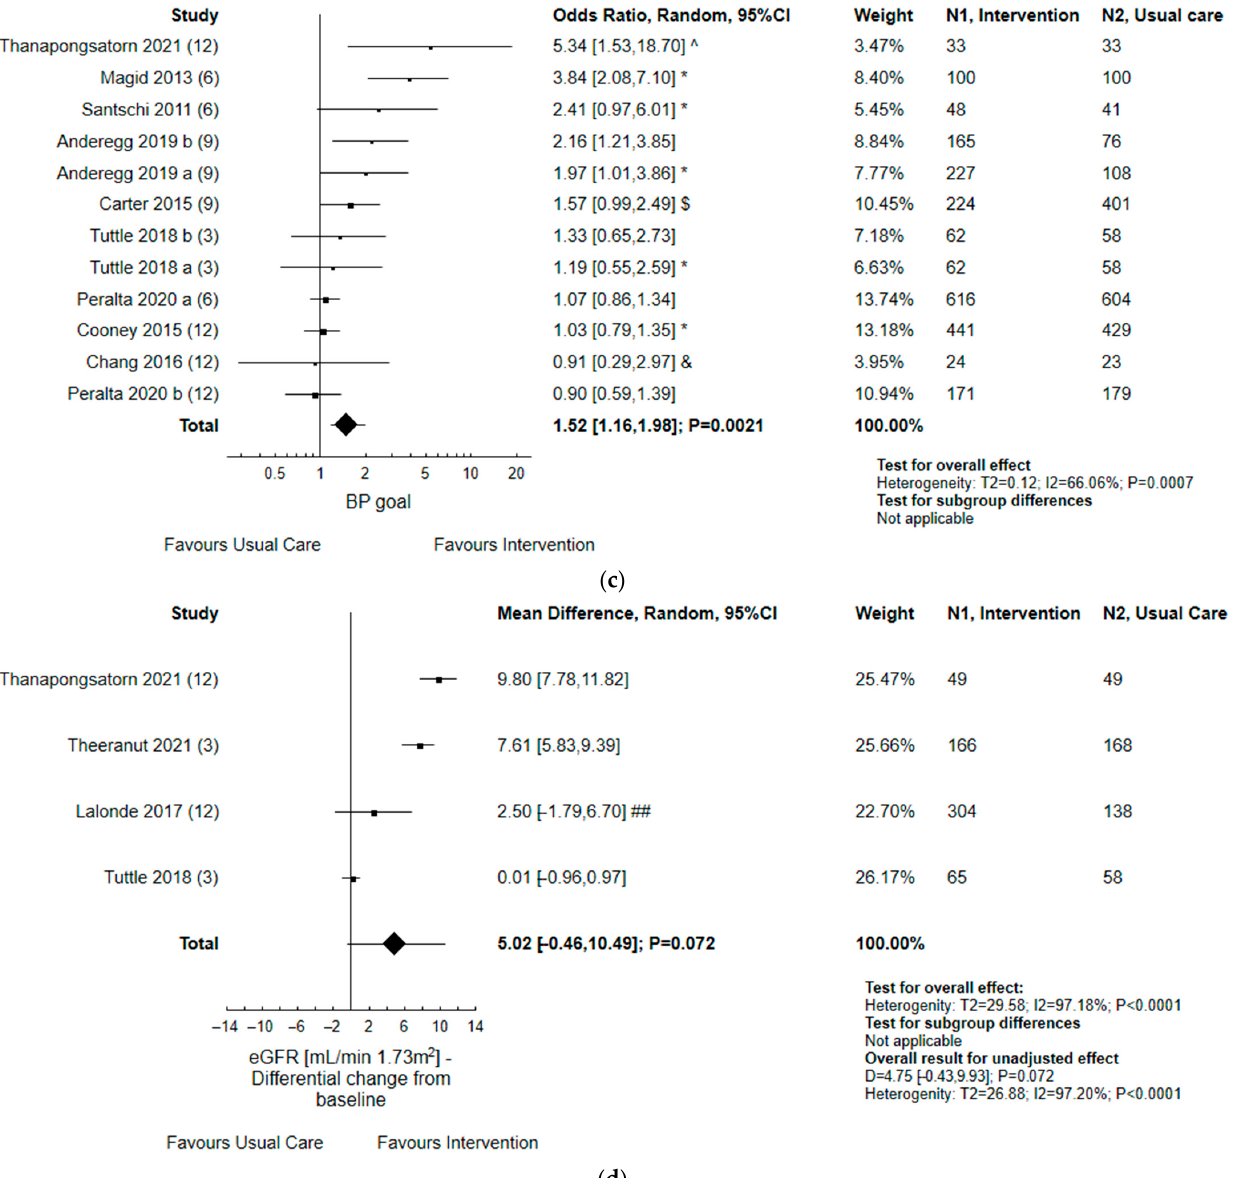
Figure 4. Forest plot of comparison: pharmacist contribution to comprehensive intervention vs. usual care for continuous and dichotomous data concerning clinical outcomes [12–15,17–22,24,27–29,36,37]. Differential change from baseline in SBP ( a ) and DBP ( b ); patients with an achieved BP goal ( c ); differential change from baseline in eGFR ( d ); #—adjusted for sex, baseline systolic BP, smoking status, body-mass index, and cluster characteristics (mean pharmacist year since graduation); ##—adjusted for the clinical variable at baseline (eGFR), interaction between study group and clinical variable at baseline, and patient’s age, sex, highest level of education, and eGFR, as well as pharmacist being an associate clinician and receiving remuneration for pharmaceutical opinions; BP goal was defined as <140/90 mmHg, except for: &—140/90 mmHg for non-proteinuric CKD and <130/80 for proteinuric CKD; ^—<140/90 mmHg for non-hypertensive patients, and <130/80 mmHg for hypertensive patients; $—<140/90 mmHg for subjects with neither condition, and <130/80 mmHg for DM/CKD patients *—<130/80 mmHg; months of follow-up were shown in brackets.